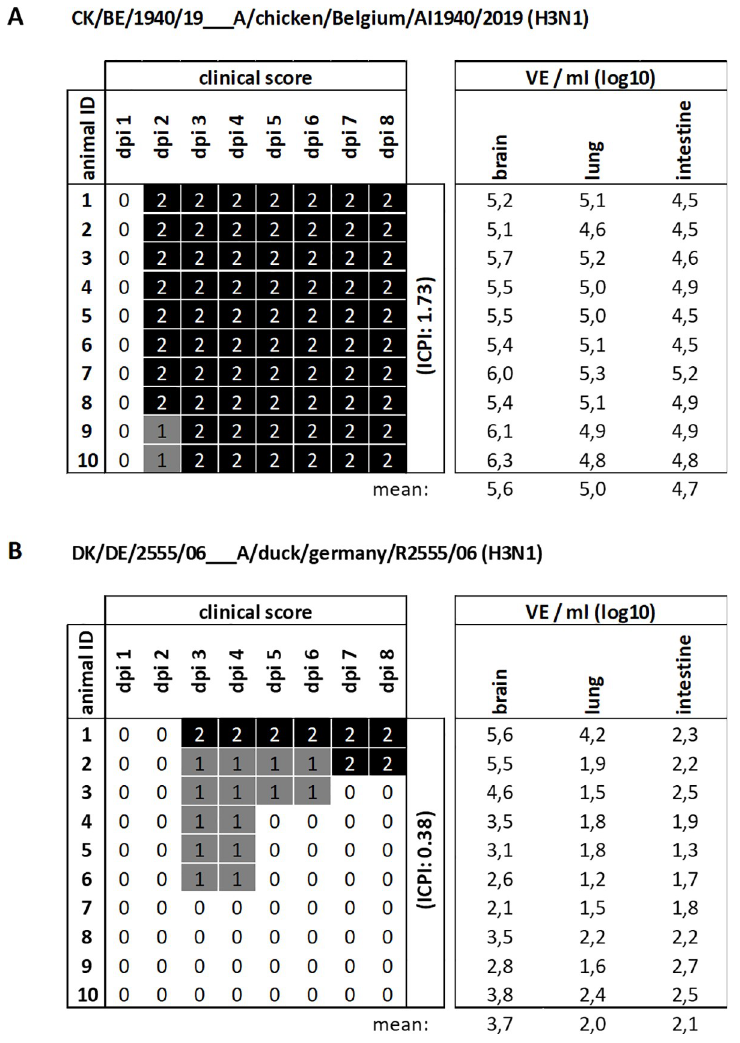
Fig 2. Intracerebral inoculation of chickens with H3N1 AIV: Clinical course and virus genome in organs. Day-old SPF chicks were inoculated intracerebrally either with (A) CK/BE/1940/19 (H3N1) or with (B) DK/DE/2555/06 (H3N1) virus isolates. The health status was scored daily over the period of eight days post inoculation (dpi), with (0) as healthy, (1) as diseased and (2) as dead. The ICPI is calculated as the mean score per bird per observation over the 8-day period (1 observation per bird per day). Organ samples were taken on day of death or 8 dpi and analyzed for virus genome load, presented here as infectious virus equivalents (VE)/ml, calculated by correlation of cq values to a standard curve of the respective virus stock with known